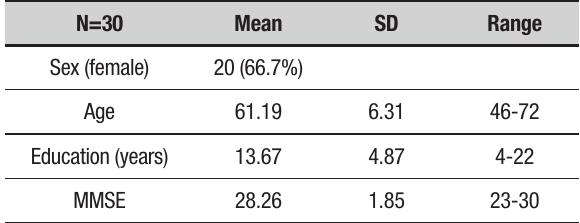
Table 1. Demographic data.